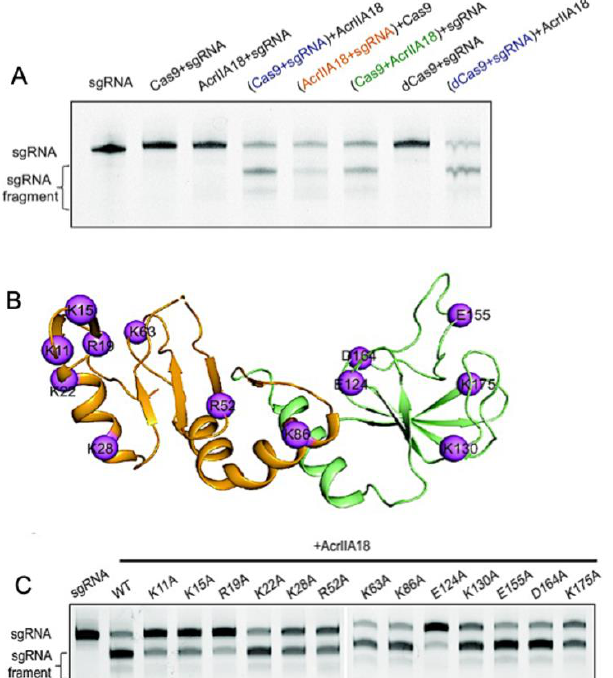
Figure 6. Enzymatic modification of Cas9 nucleic acids by Acrs. ( A ) Denaturing gel demonstrating that AcrIIA18 digests gRNA in a Cas9-dependent manner. ( B ) Sites of hypothesized functional importance in AcrIIA18 based on charge complementarity to Cas9 (purple spheres). ( C ) Alanine mutations at the highlighted sites in ( B ) modulate the ability of AcrIIA18 to enzymatically cleave gRNA. Figure is reprinted/adapted from Wang, X. et al. Inhibition mechanisms of CRISPR-Cas9 by AcrIIA17 and AcrIIA18 [53].